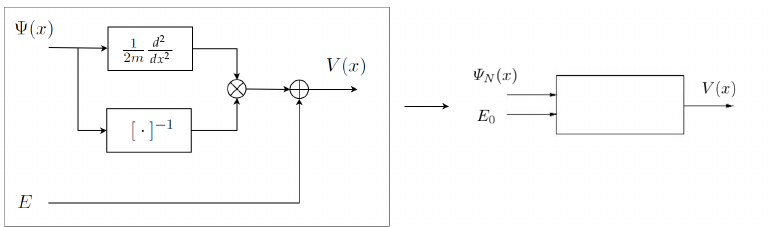
Figure 3. Identifiable system for the quantum mechanical bound state problem in one dimension. On the left side, the underlying dynamical system is shown, while on the right side, the simplified sketch of the MISO system in question is shown, where Ψ N ( x ) is the normalized wave function and E 0 is the energy of the first bound state.